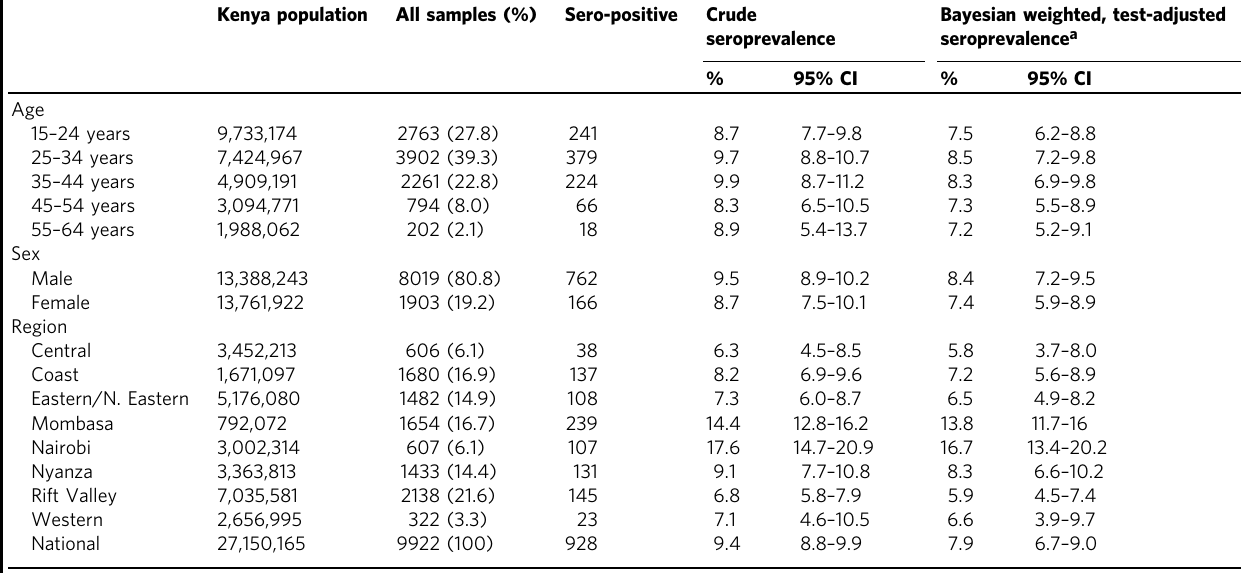
Table 1 Crude, age/sex standardised and Bayesian-weighted test-adjusted SARS-CoV-2 anti-spike protein IgG seroprevalence across the whole study duration.